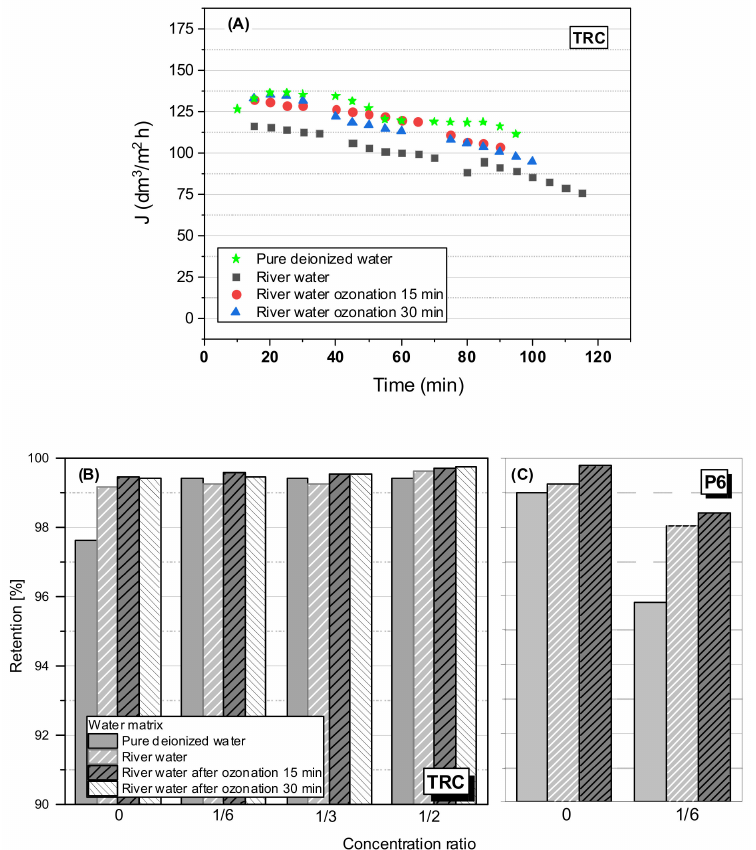
Figure 10. ( A ) The filtrate flux for a different water matrix with dissolved TRC; ( B ) TRC retention for different water matrix; ( C ) P6 retention for different water